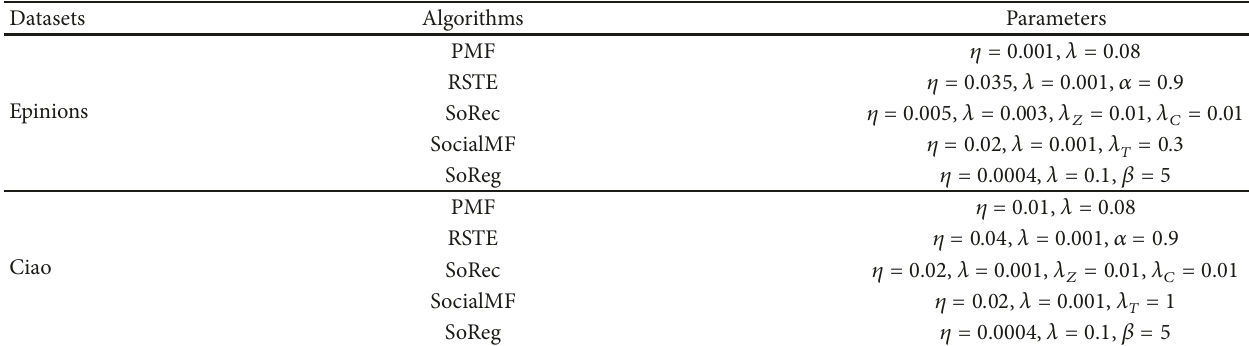
Table 2: Parameter settings of compared recommendation methods.